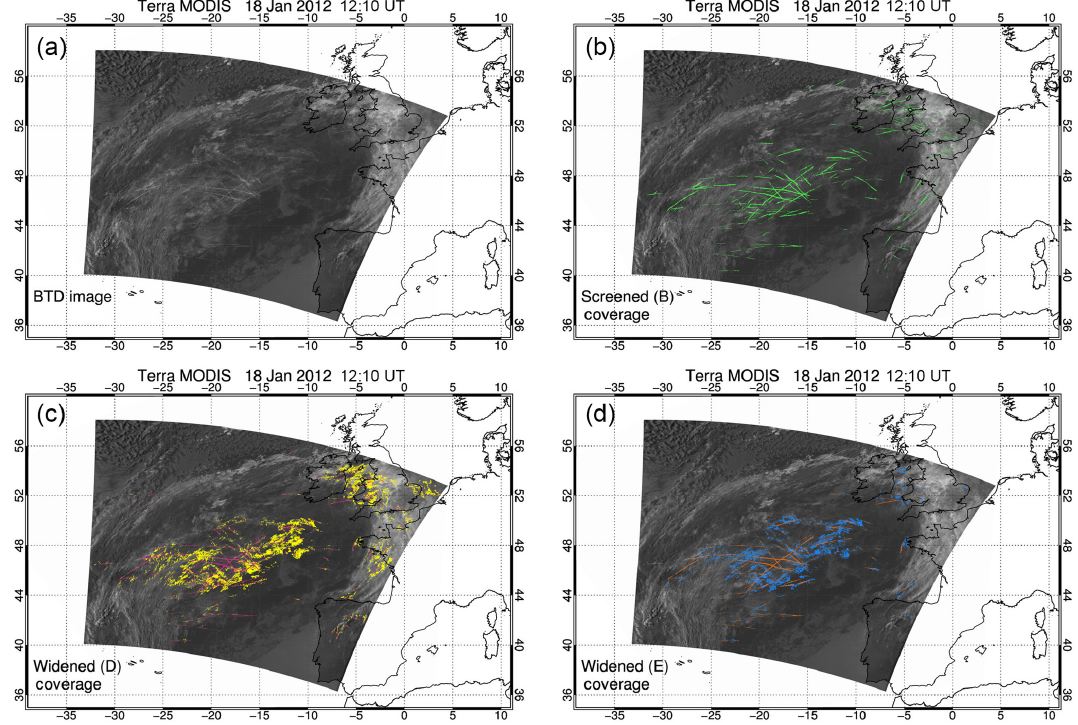
Figure 9. (a) Map of 11–12µm brightness temperature difference (BTD) from 5min Terra MODIS granule starting at 12:10UT on 18 Jan- uary 2012 over the eastern North Atlantic. (b) Similar to (a) but with Mask B screened coverage in green. (c) Similar to (a) but including Mask D linear contrails in pink and contrail cirrus in yellow. (d) Similar to (c) but containing Mask E linear contrails as orange pixels and contrail cirrus as light blue